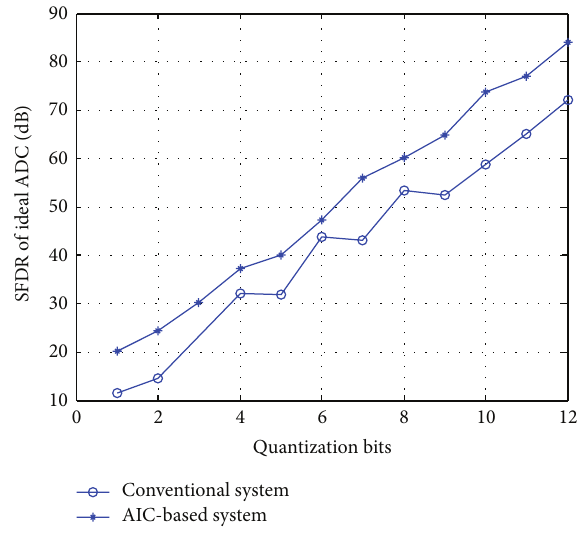
Figure 2: SFDR performance of AIC-based system and ADC-based with ideal